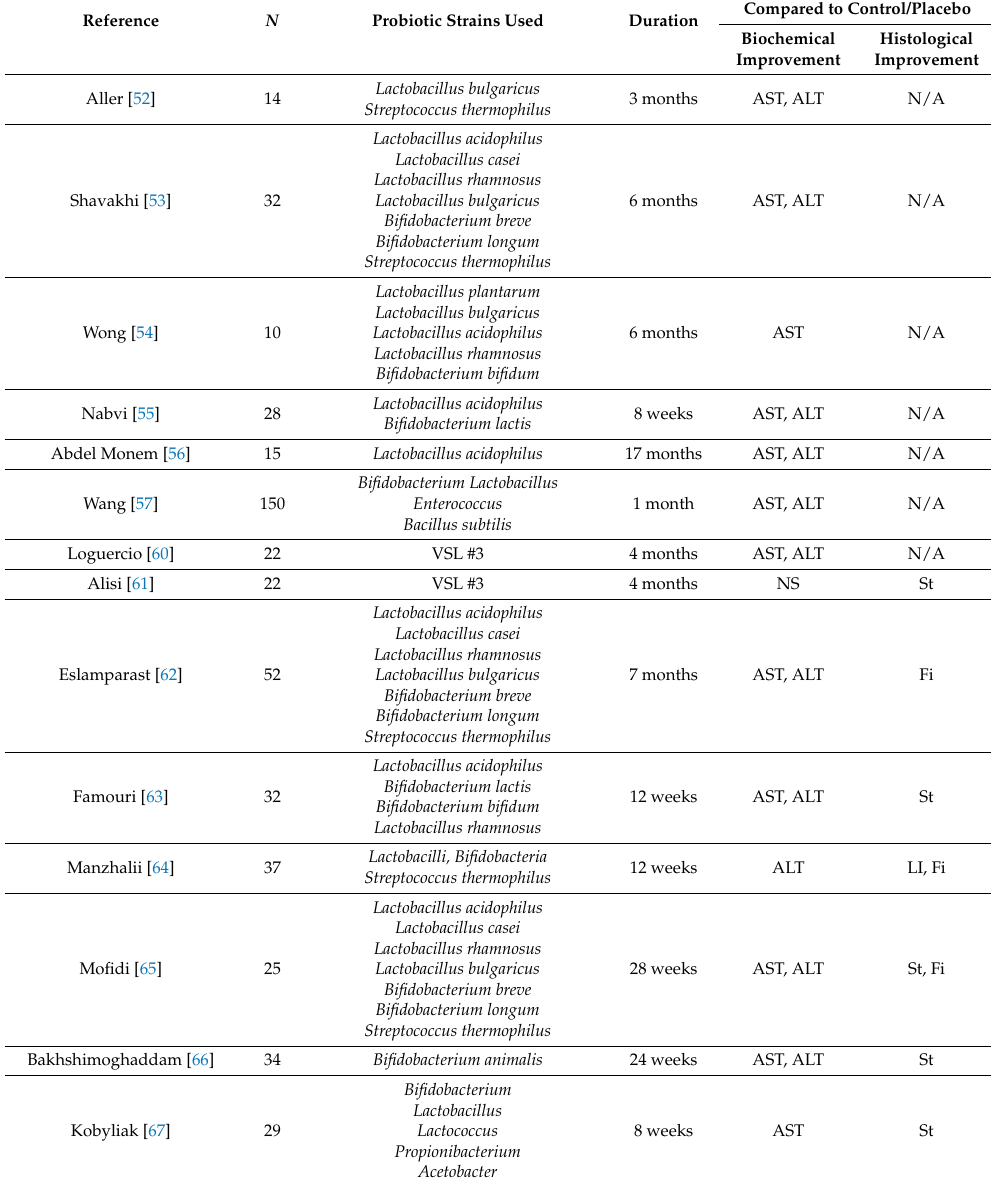
Table 1. Major clinical studies using probiotic therapy for